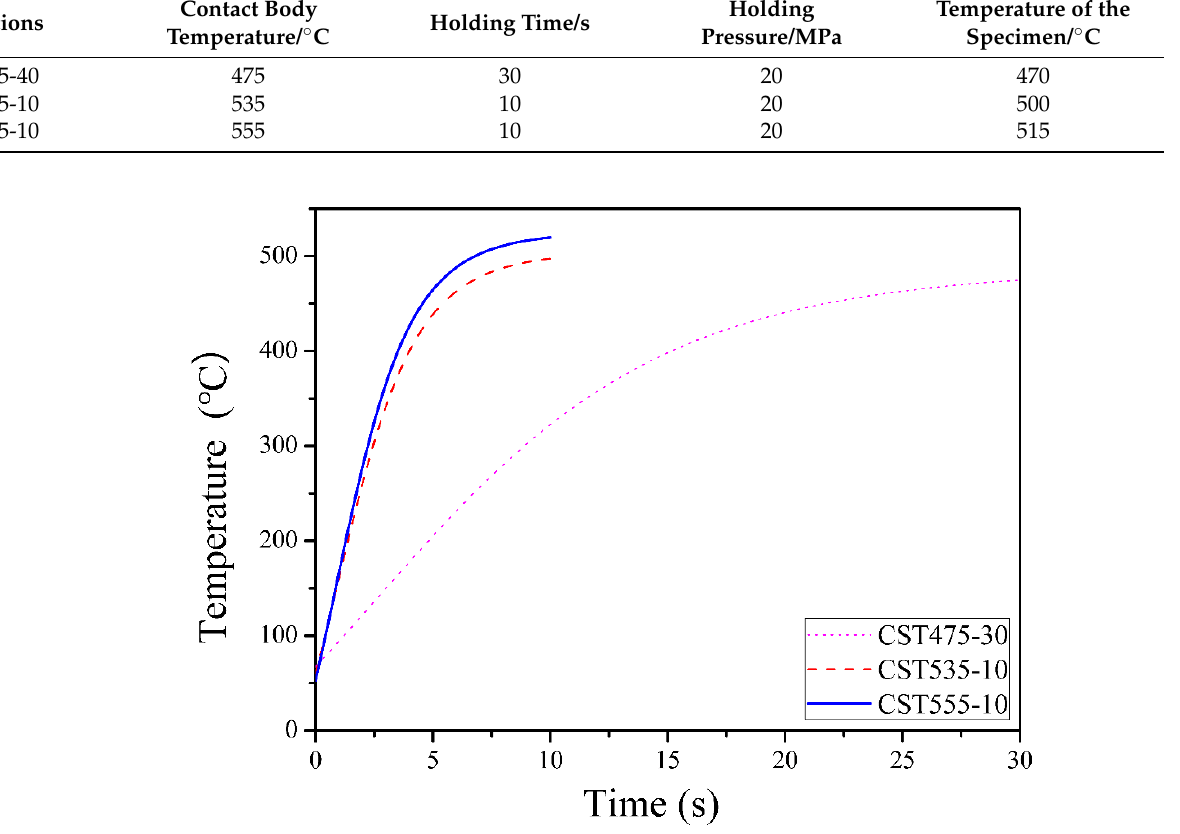
Figure 2. Temperature variation curves of specimens with different CSTs .